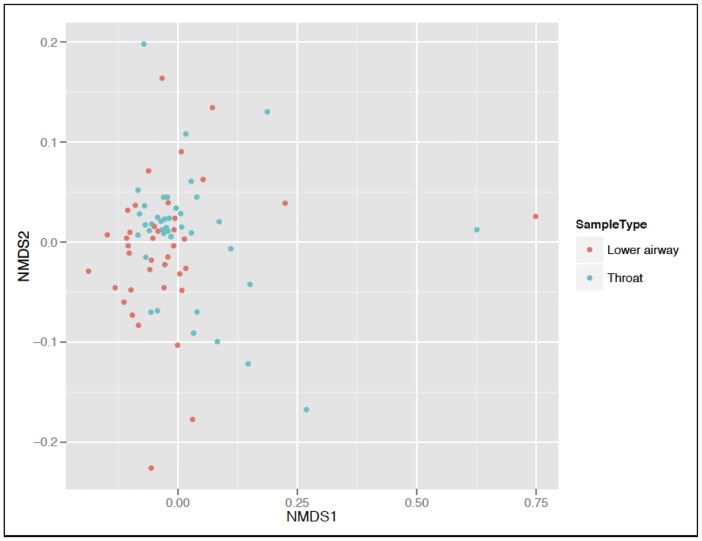
Non-metric multidimensional scaling (NMDS) plot comparing the UniFrac score between patients.This shows similarity in the clustering pattern between lower airway samples and throat swabs.